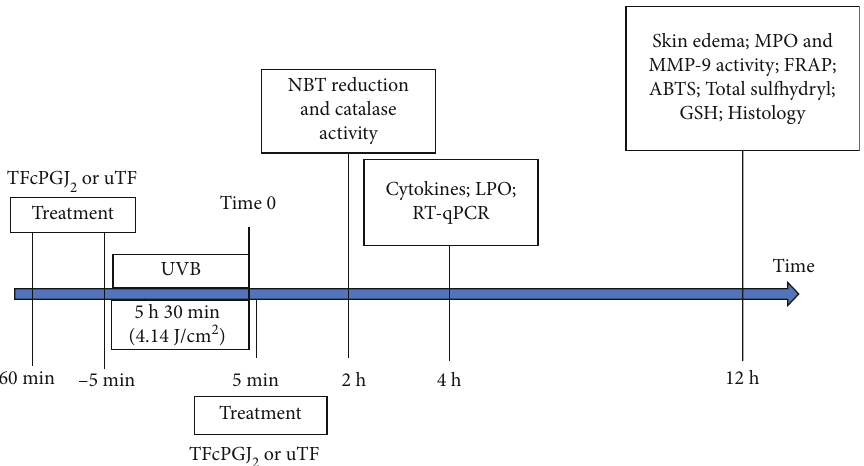
Figure 1: Schematic protocol approaching the treatment with topical formulation containing 15d-PGJ collection, and parameters analyzed at each time point. Mice were treated with TFcPGJ 5min before the beginning of irradiation and 5min after the irradiation. Dorsal skin samples were collected 12h after the exposure to UVB irradiation for skin edema, MPO and MMP-9 activity, FRAP, ABTS, total sulfhydryl, GSH levels, and histology. Samples were collected after 2 hours of exposure to UVB for the tests of catalase and superoxide anion production (NBT reduction). Finally, samples collected 4 hours after the end of the irradiation were tested for cytokines and lipid peroxidation (LPO) and mRNA expression by